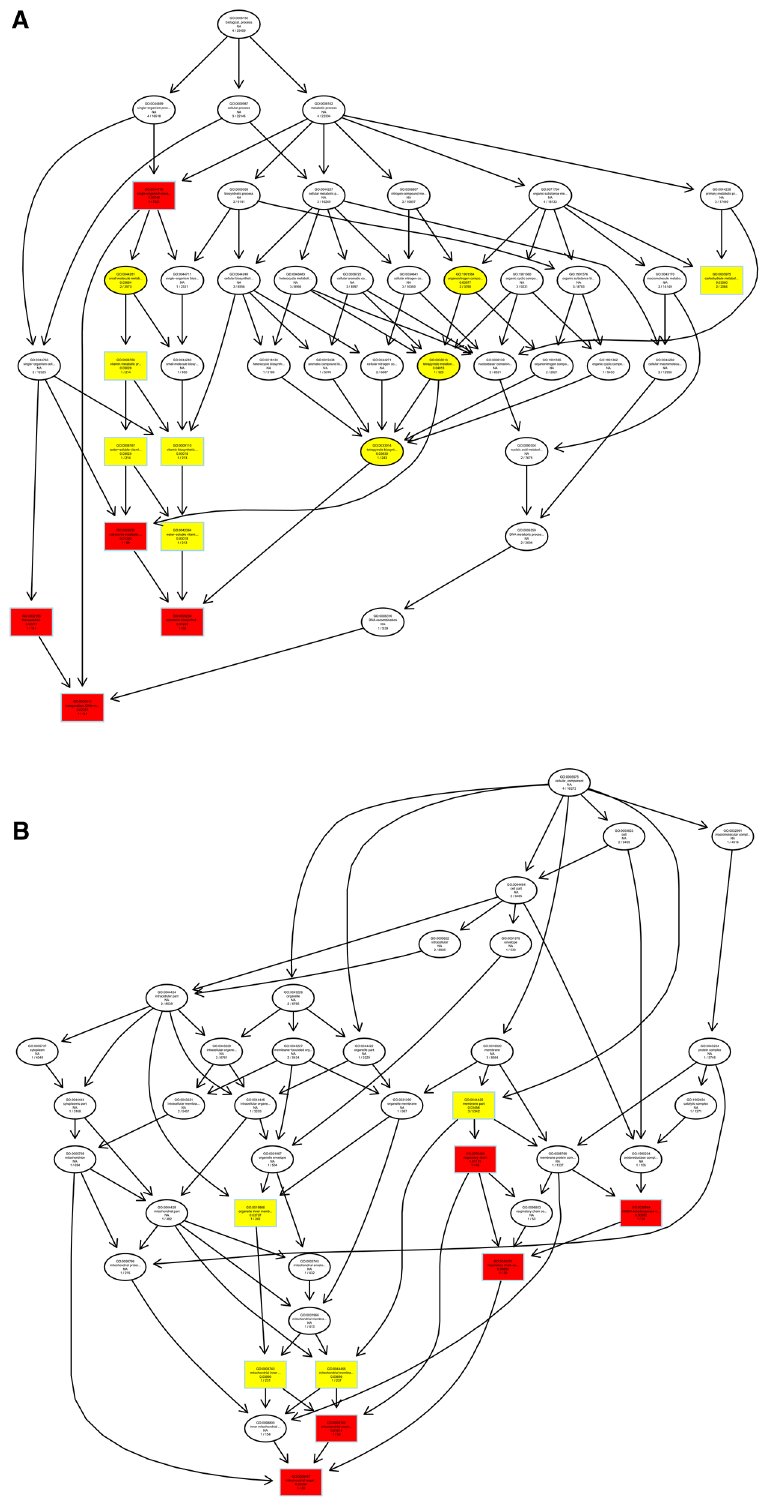
Figure 7. Differentially expressed circRNAs in ginseng tissues predicted the GO enrichment analysis of target genes. ( A ) The directed acyclic graph of the BP part; ( B ) the directed acyclic graph of the CC part; ( C ) the directed acyclic graph of the MF part; ( D ) statistical histogram. Image generated with R 3.6.3 (https:// www.R- proje ct. org) 51 ggplot2 package (https:// ggplo t2. tidyv erse.